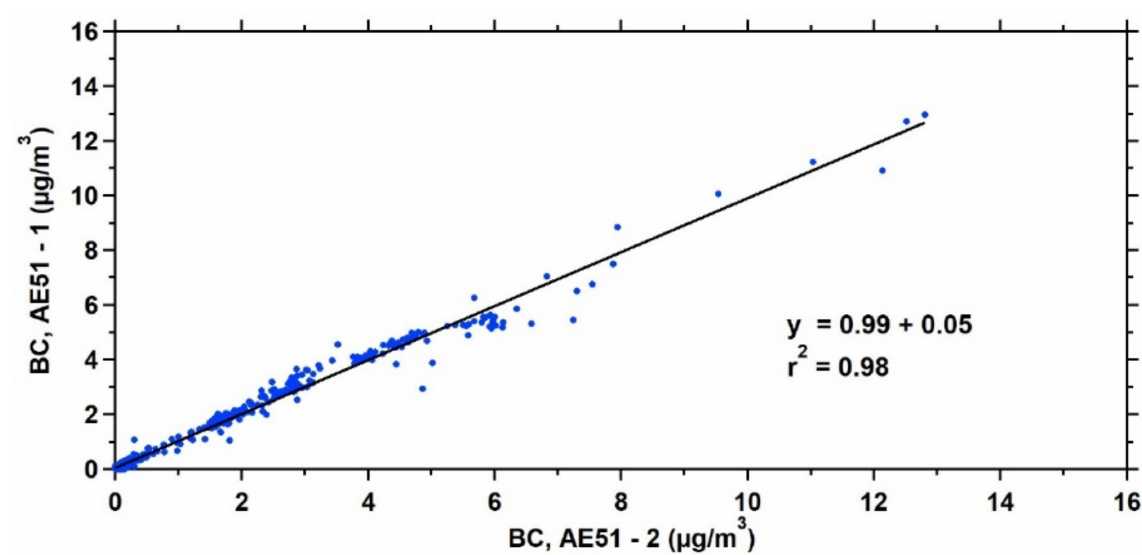
Figure A1. Intercomparison of the two BC monitors (microAeth AE51) used during the study period by the participants. The black line shows the linear regression fit to the